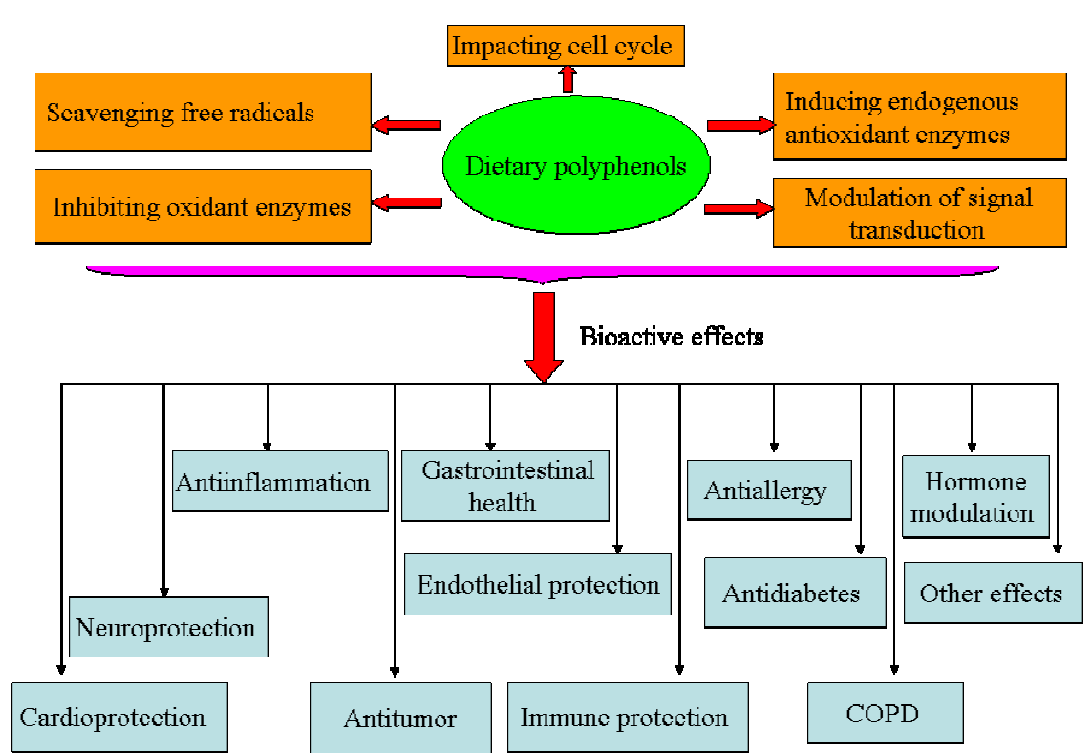
Figure 2. Bioactivities of dietary